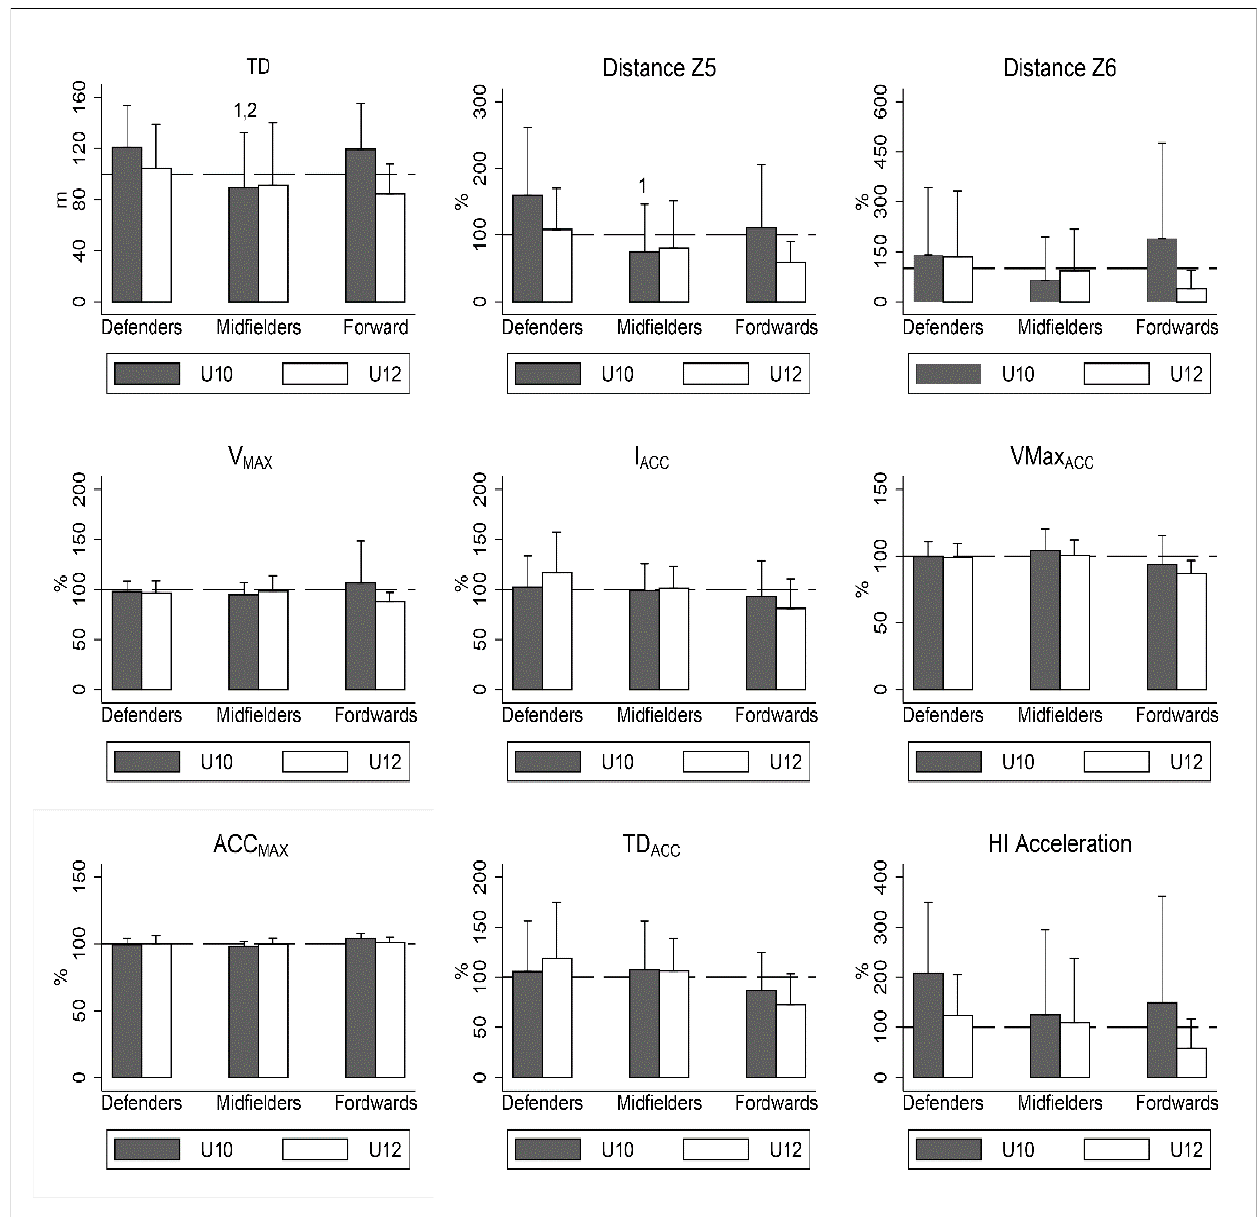
Figure 1. Training load metrics for U10 and U12 players relative to competitive match play. Data are presented across positions: defenders (DFs), midfielders (MFs), and forwards (FWs). TD = total distance; distance Z5: distance zone 5; distance Z6: distance zone 6; V MAX = maximum speed; I ACC = time interval between accelerations; VMax ACC = average maximum speed acceleration; ACC MAX = maximum acceleration; TD ACC = average distance travelled in acceleration greater than 2.5 m·s −2 ; HI acceleration = number of high-intensity accelerations; 1 = differences between DFs and MFs; 2 = differences from FWs.